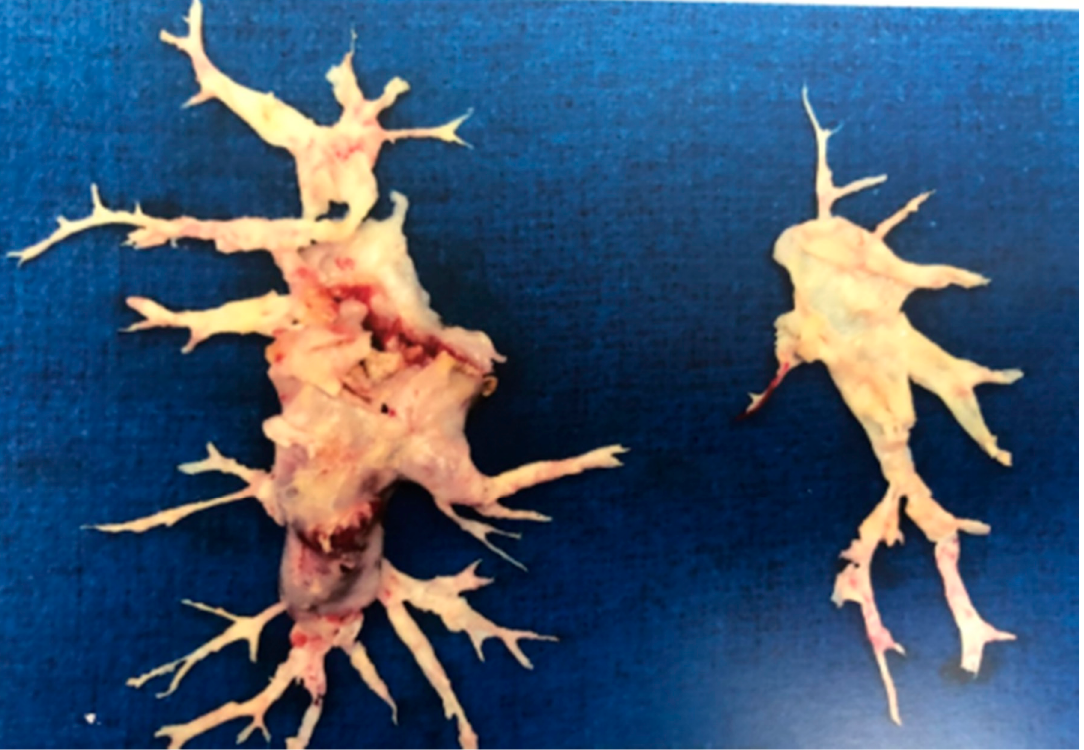
Figure 4. Specimen removed (both left and right) after pulmonary endarterectomy in a patient with chronic thromboembolic pulmonary hypertension.